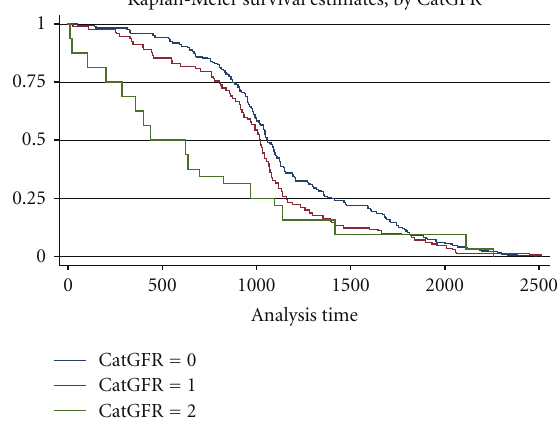
Figure 2: Kaplan-Meier curves for survival based on GFR. CatGFR: 0 implies GFR ≥ 60; catGFR: 1 implies GFR 30–59; catGFR: 2 implies GFR <